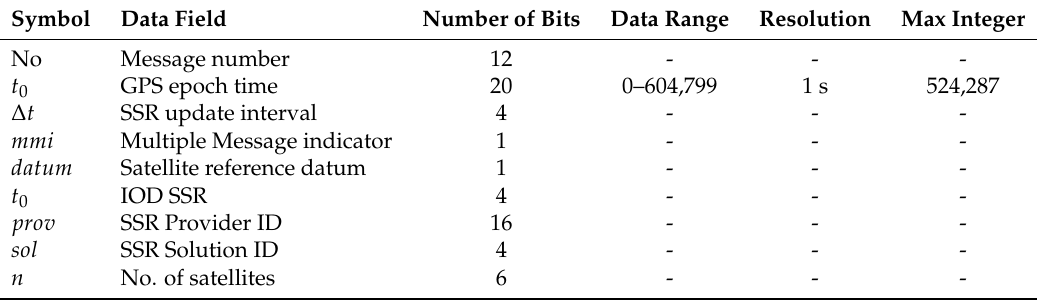
Table 1. Header part of RTCM 10,403.2 message 1057.